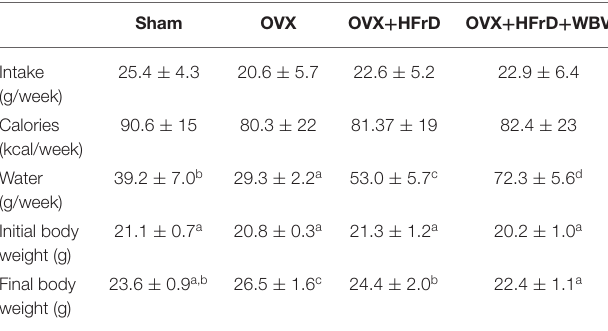
TABLE 2 | The body weight and dietary intakes with OVX, HFrD, and WBV intervention.